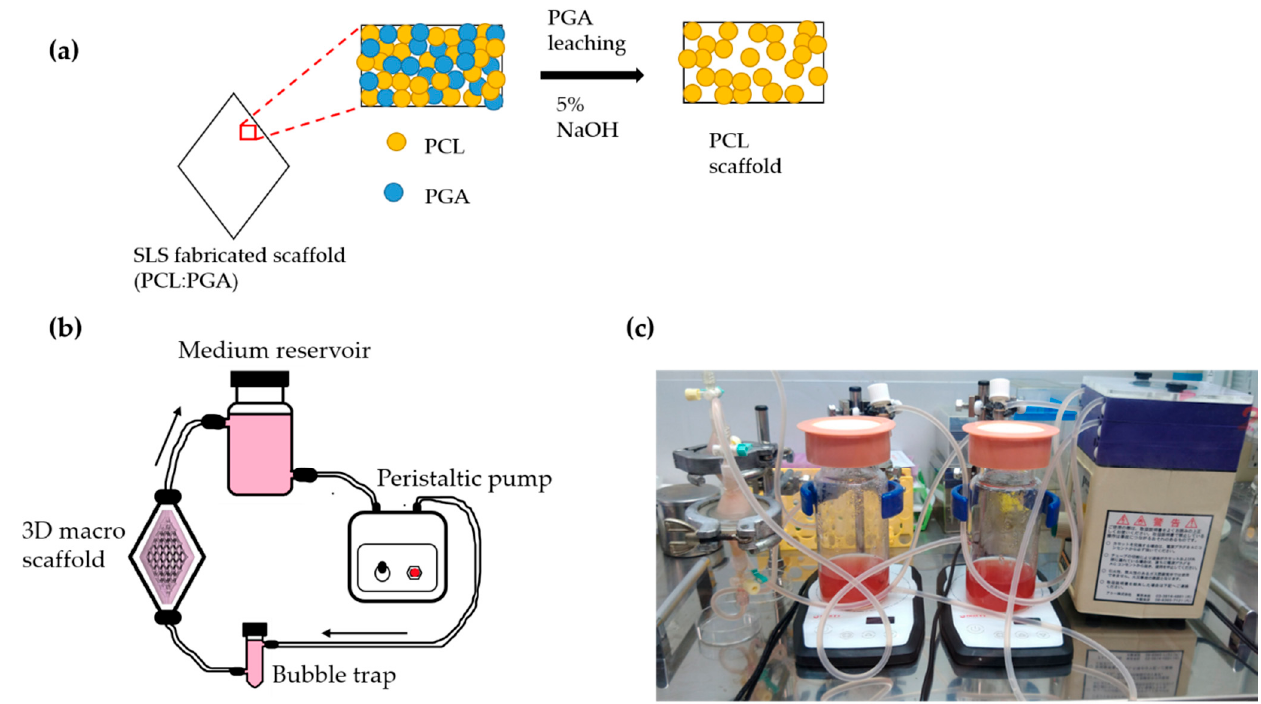
Figure 1. ( a ) Schematic illustration of polyglycolic acid (PGA) leaching using 5% NaOH to produce porous polycaprolactone (PCL) macro scaffold postprocessing of SLS printing; ( b ) schematic illustration of perfusion culture setup consisting of peristaltic pump, bubble trap, scaffold, and medium reservoir; ( c ) configuration of perfusion culture system.